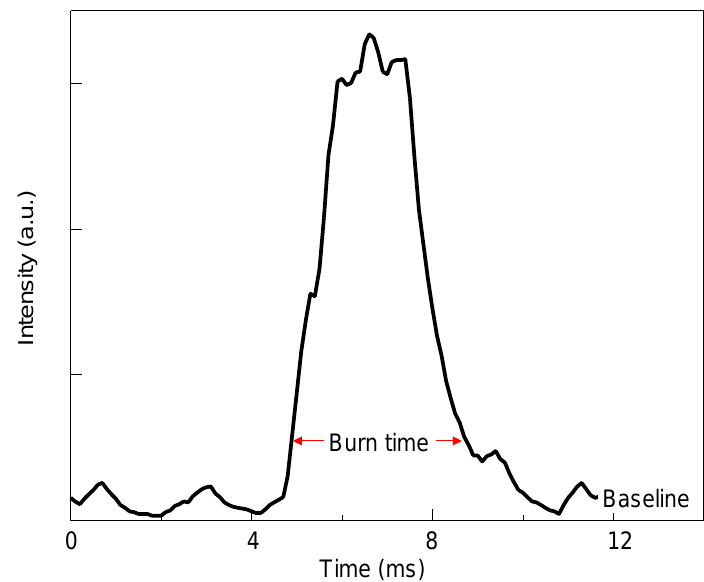
Figure 12. A representative emission pulse produced by a 50Si·50BiF 3 particle burning in air.